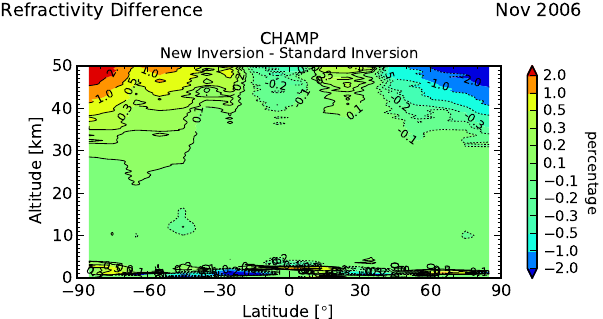
Figure 4. Relative difference between monthly mean refractivity Fig. 4 : Relative difference between monthly mean refractivity from CHAMP data, using from CHAMP data, using average-profile inversion and standard average-profile inversion and standard inversion, for November 2006. inversion, for November